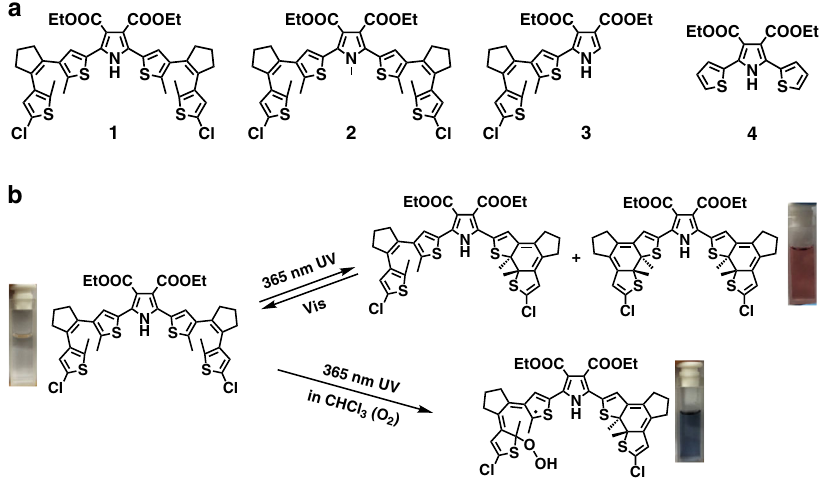
Fig. 1 Research outline. a Illustration for related chemical structures: compounds 1 – 4. b An outcome of photochromic switching and radical production processes of compound 1 controlled by light in oxygen-saturated